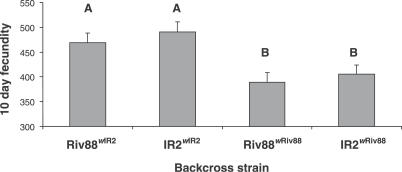
Effects of Wolbachia Strain and Nuclear Background on 10-d Fecundity of D. simulans
The nuclear background (normal text) and Wolbachia strain (superscript text) are for flies collected in Riverside in 1988 (Riv88) or Irvine in 2004 (IR2). Error bars are standard errors. Different letters indicate significantly different means (at the 5% level).